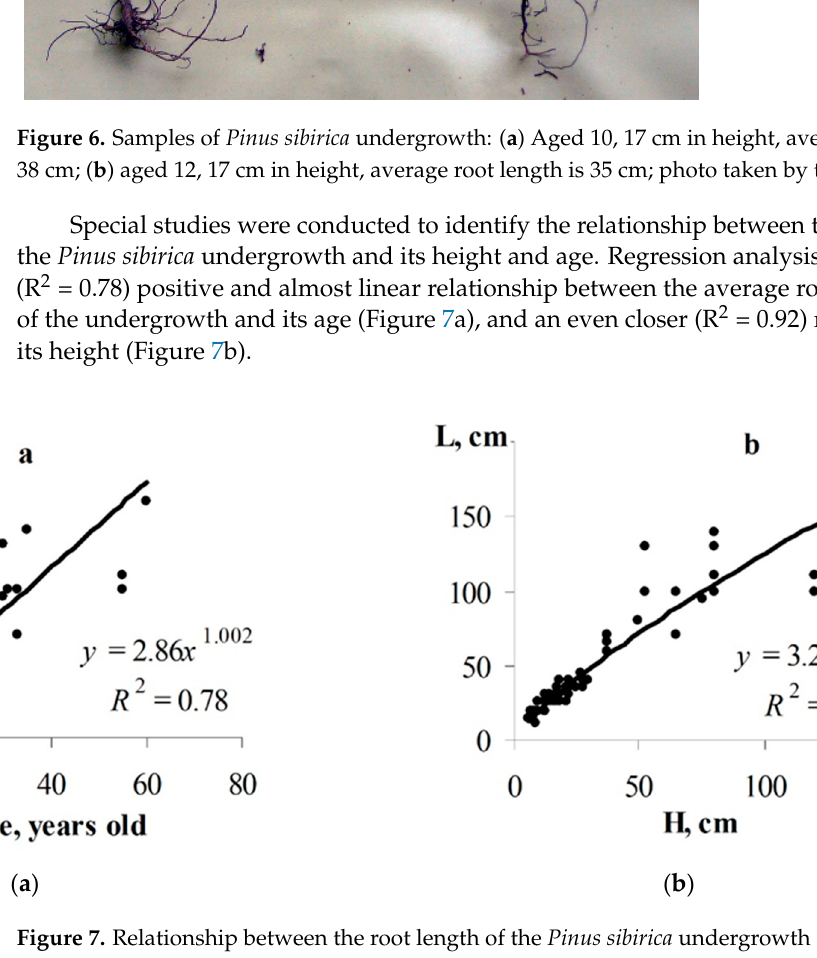
Table 4. Correlation coefficients between the number of the Pinus sibirica seedlings in the mountain tundra and air temperature and precipitation.